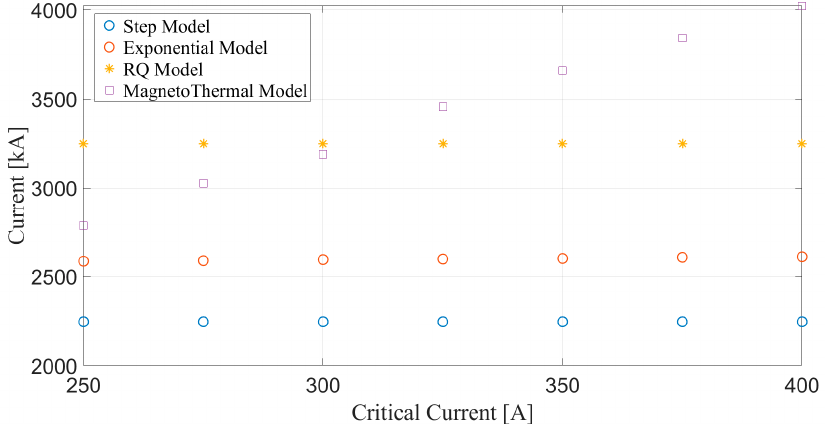
Figure 15. Model comparison for 400 A critical current and 5 Ω fault resistance.